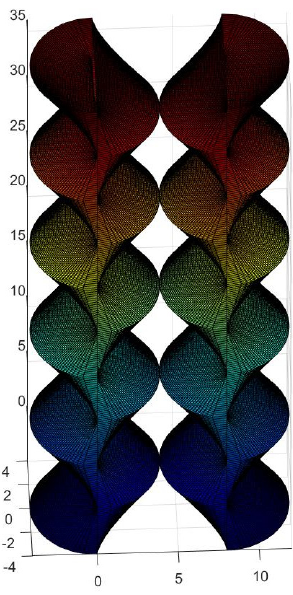
Figure 42. A symmetric array of twin